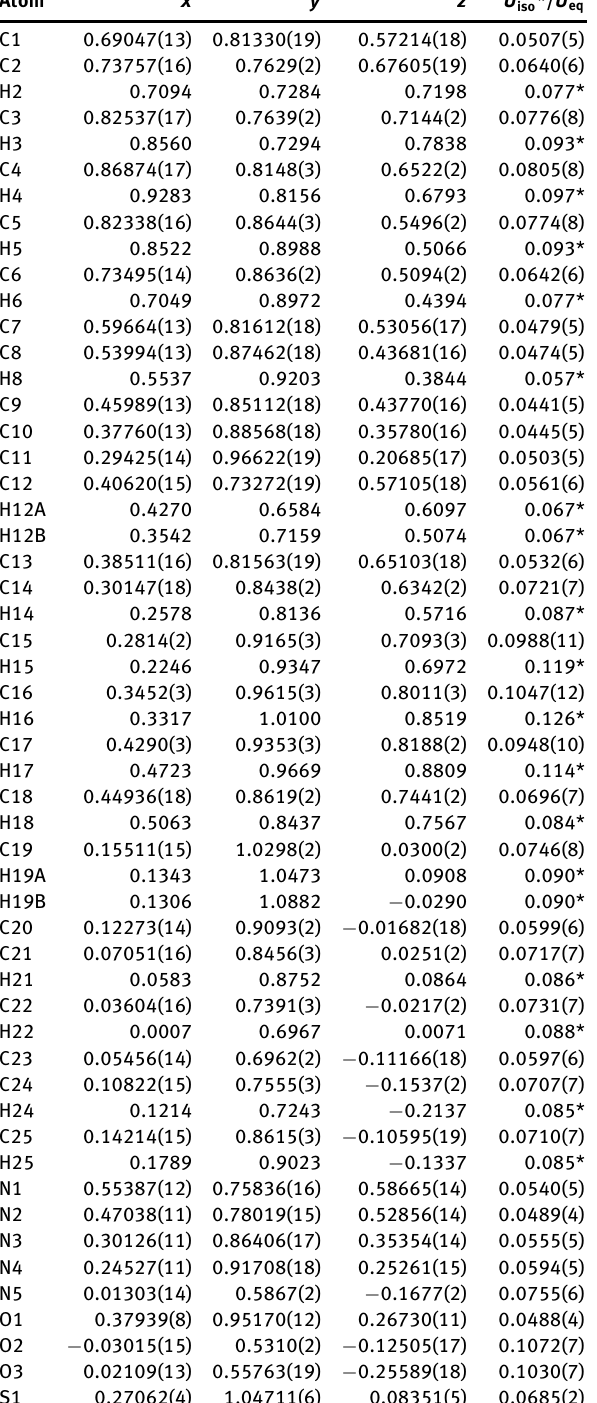
Table 2: Fractional atomic coordinates and isotropic or equivalent isotropic displacement parameters (Å 2